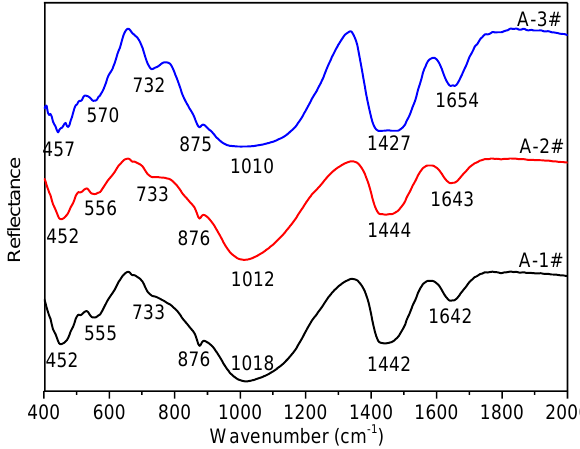
Figure 11. SEM images of samples with different Ms under the C-1 curing conditions after 28-day: